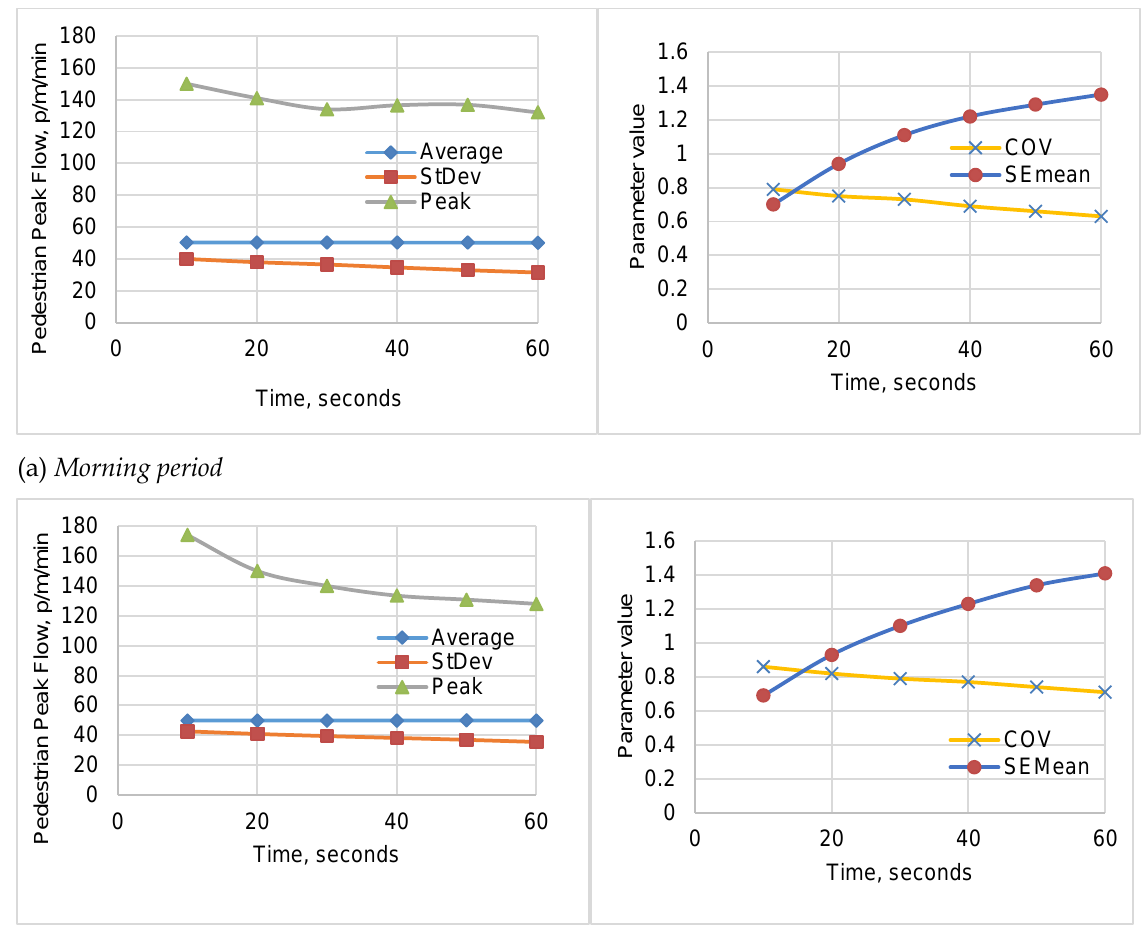
Figure 6. Variation in Statistical Flow Attributes and Parameters up to 60s Interval Examination of the variations indicated that the 98 th percentile peak flow value during morning and evening periods (i.e., 138 ped/m/min and 147 ped/m/min respectively), relates to 24s